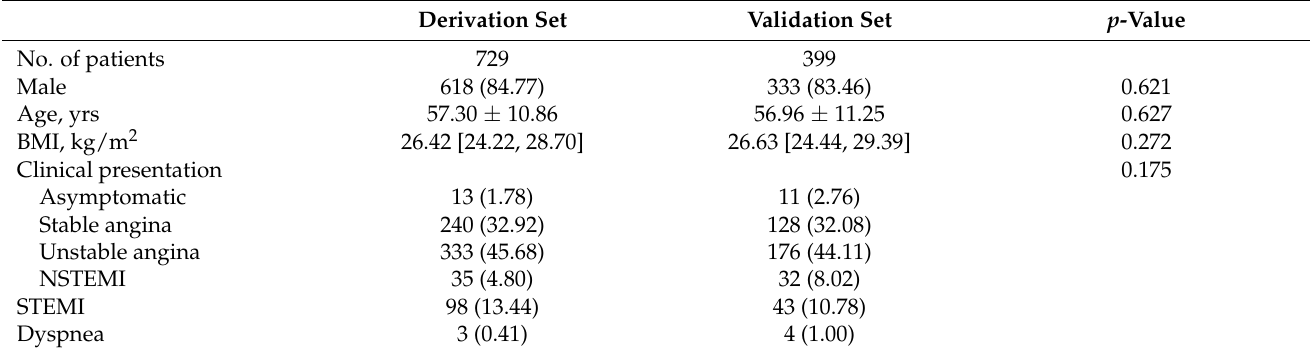
Table 1. Baseline characteristics of the derivation dataset and validation